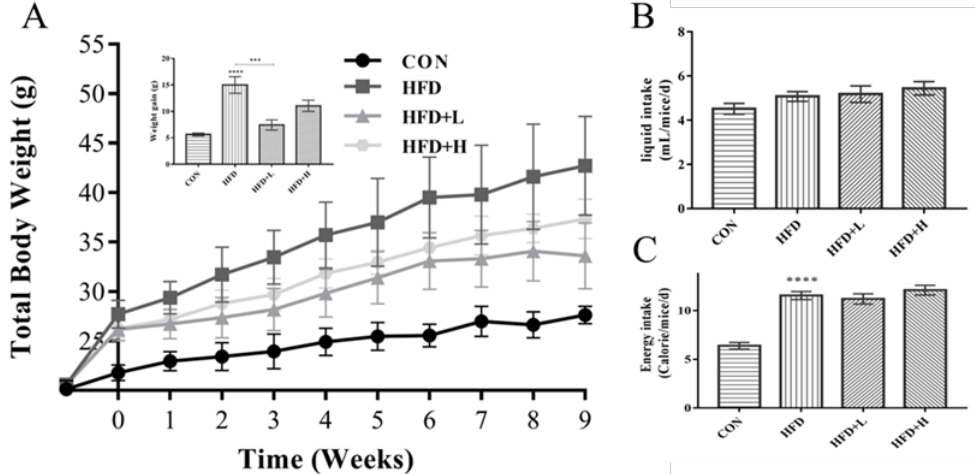
Figure 2. Changes in body weight gain, fluid intake, and energy intake of mice in each group. ( A ) Growth curve of total weight gain in each group ( n = 7); ( B ) average fluid intake in each group (mL/mice/d); ( C ) average energy intake of each group (kcal/mice/d). Data were shown as mean ± SEM. *** p < 0.001, and **** p < 0.0001 compared with the other